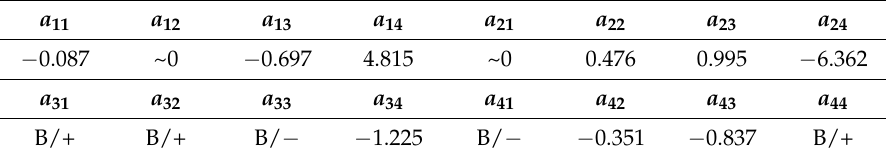
Table 3. Mean values of interaction parameters of model #2 (“B” stands for “bimodal distribution”, the sign of the interaction being specified by B/+ or B/ − ).